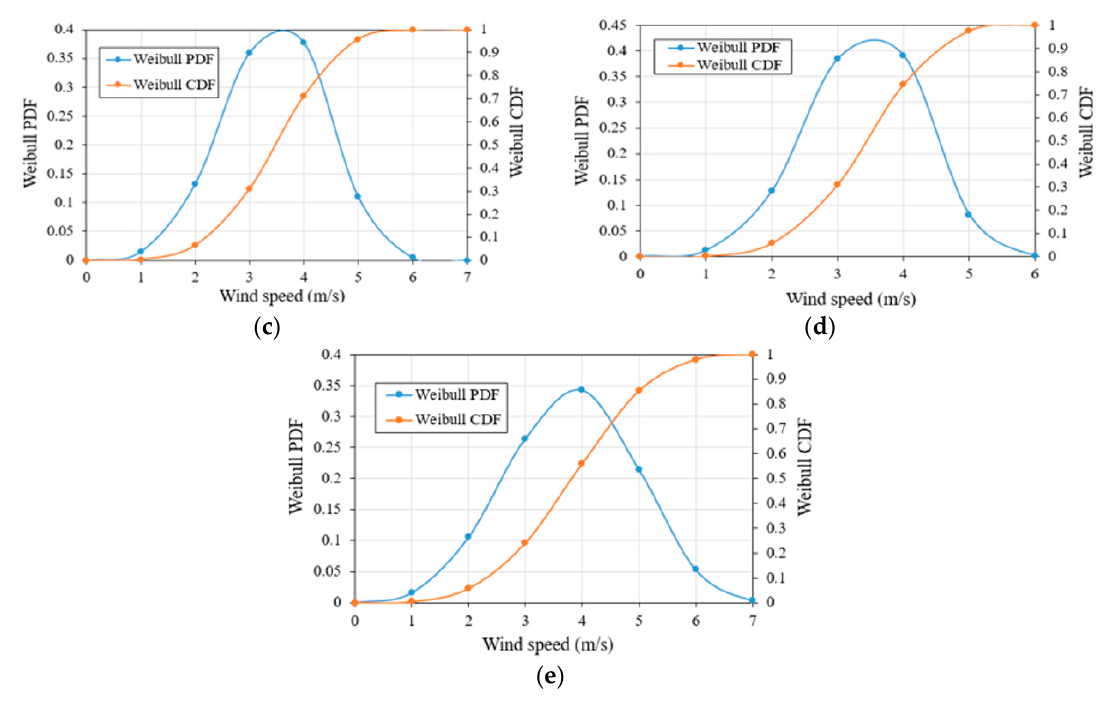
Figure 4. Weibull distribution of Deokjeok-do from 2005 to 2015 at 10 m from the local ground ( a ) Winter; ( b ) Spring; ( c ) Summer; ( d ) Autumn; ( e ) Overall. Tables 3 and 4 represent all of the important statistical parameters indicating the wind potential at Baengnyeong-do and Seo-San, respectively. Table 3. Long term wind data analysis of Baengnyeong-do at 10 m from local ground.